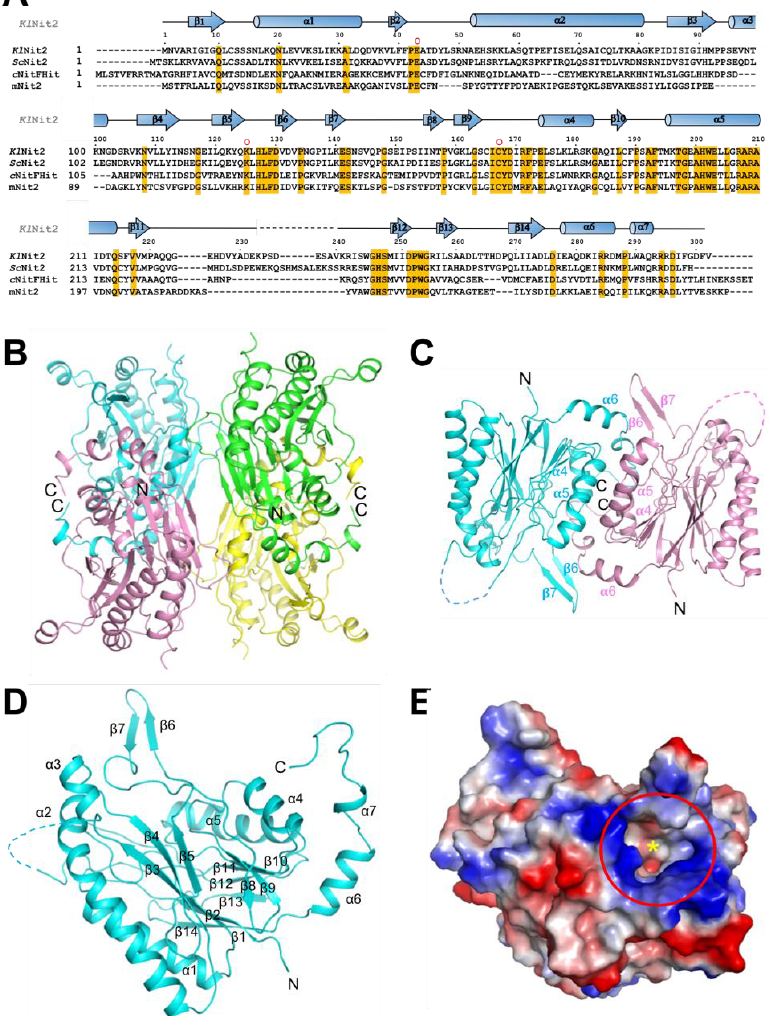
Figure 1. Overall structure of KlNit2. ( A ) Sequence alignment of KlNit2, ScNit2, mNit2, and the Nit region of cNitFhit. The secondary structure elements of KlNit2 are highlighted at the top of the sequences. Black dots above the sequences indicate every tenth residue in KlNit2. Identical residues within KlNit2 and its homologs are highlighted in yellow and the key residues of the active site are marked by a red circle on the sequences. ( B ) The tetrameric structure of KlNit2 is shown in a ribbon diagram. ( C ) The dimer structure of KlNit2. One monomer is shown in cyan; the other is colored light pink. The dashed lines show the regions that were not visible in the electron density map. ( D ) The monomer structure of KlNit2. The dashed line shows the region that was not visible in the electron density map. ( E ) The electrostatic surface model of the KlNit2 monomer. Red and blue represent the negatively and positively charged surfaces, respectively. The active site is highlighted in a red circle. The figures were generated using the graphics program PyMOL (Schrödinger Inc., New York, NY, USA).